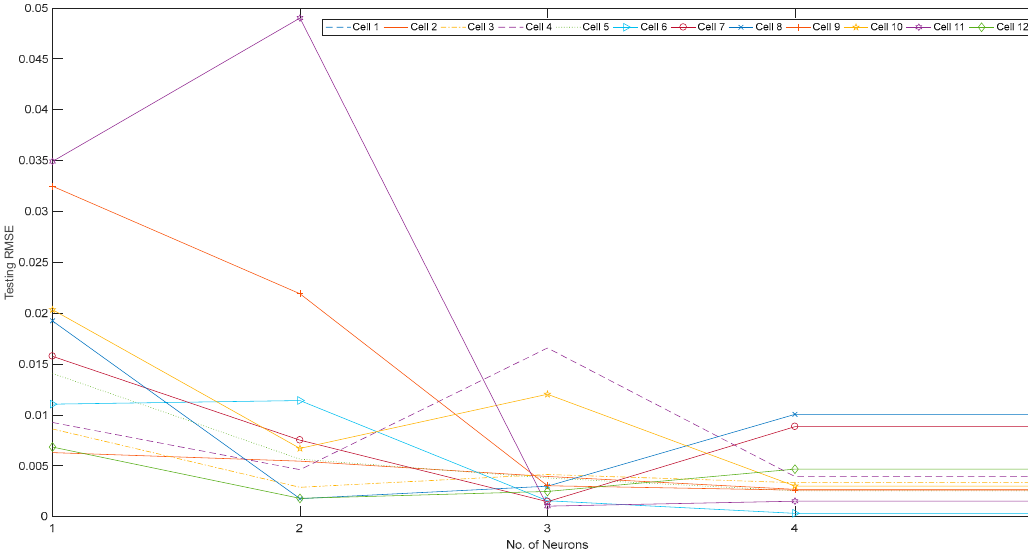
Figure 20. Testing RMSE for a 12-cell battery at 25 °C for five neurons (N0 = 200, block range = 847, sinusoidal activation function).